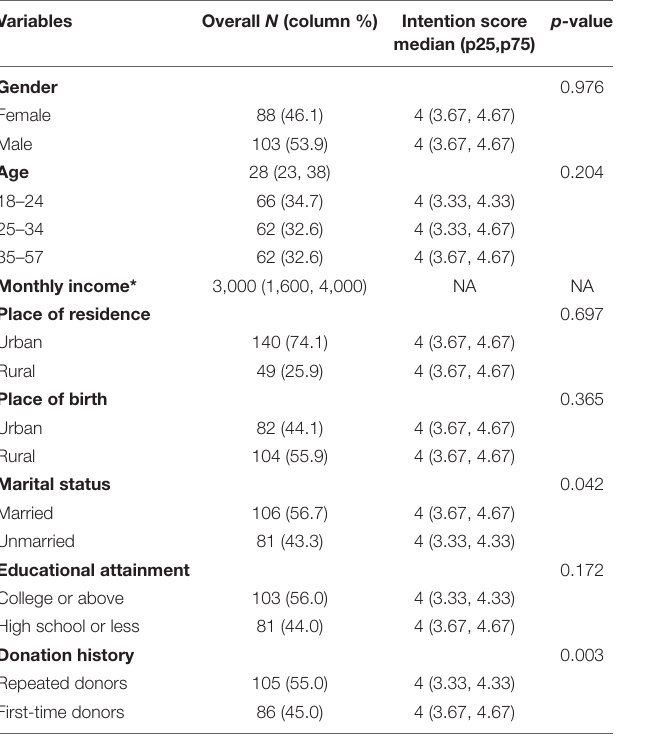
TABLE 2 | Comparison of intention score to donate again by demographic characteristic.